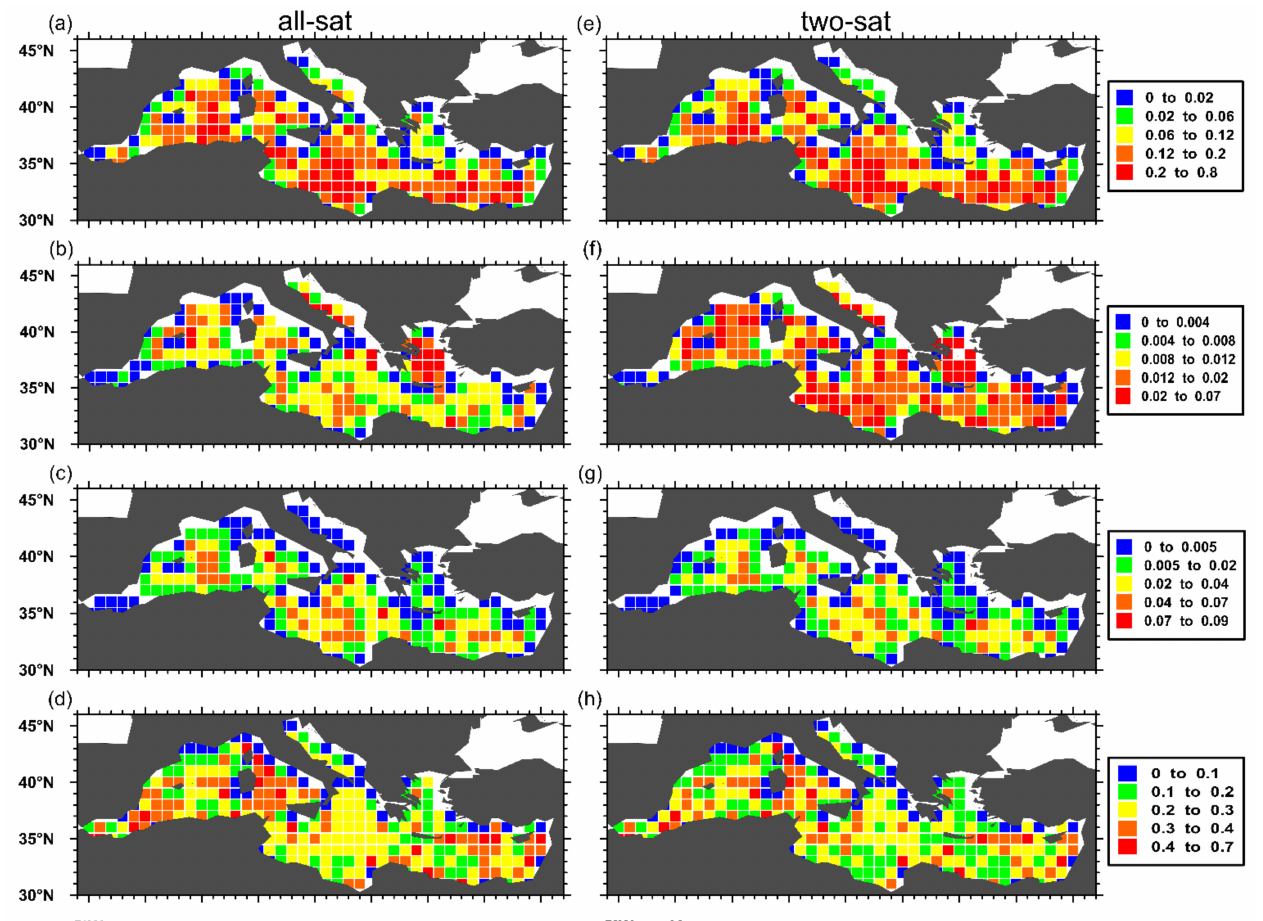
Figure 8. Density distribution of four matching situations in the Mediterranean Sea: ( a , e ) Situation A; ( b , f ) Situation B; ( c , g ) Situation C; ( d , h ) Situation D (See Section 2.2.3 for a description of the four situations). On the left are the results using the all-sat data, and on the right are the results using the two-sat data. The legend on the right shows the range of density values.